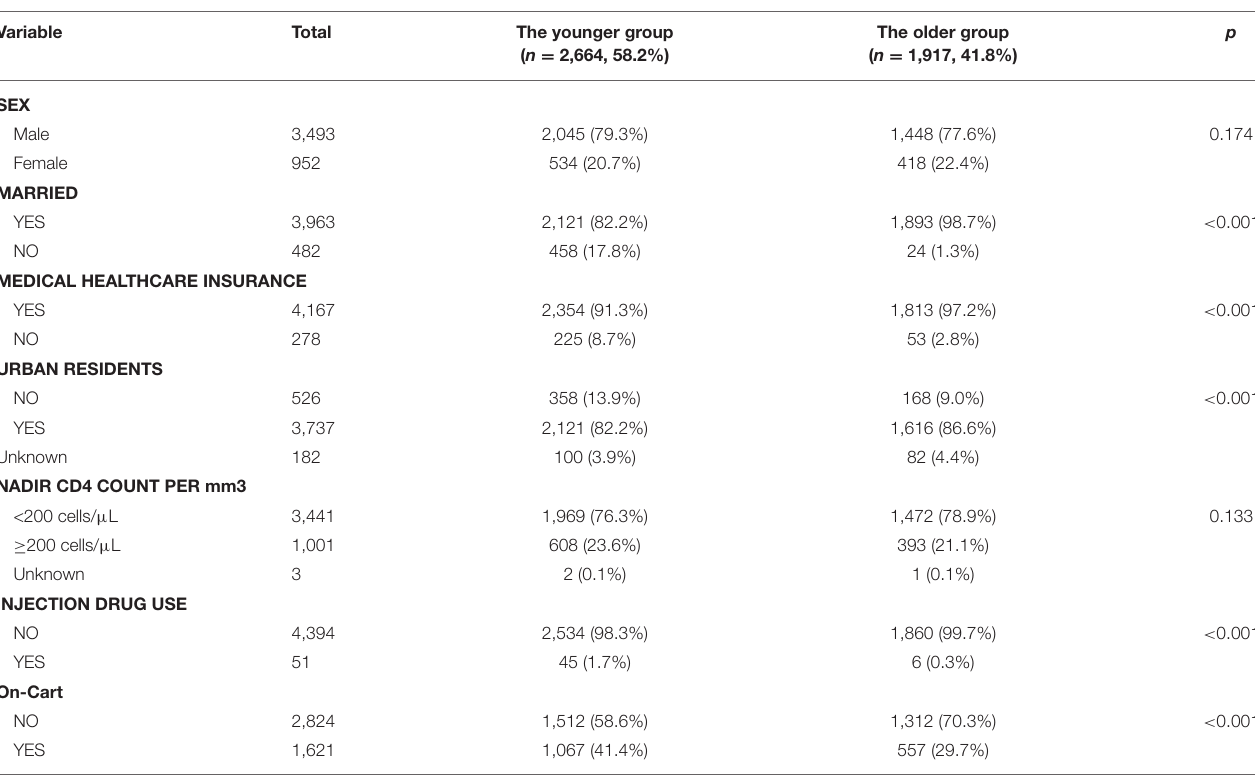
TABLE 1 | Baseline characteristics of 4,445 hospitalized PLWH, stratified by age. Variable Total The younger group